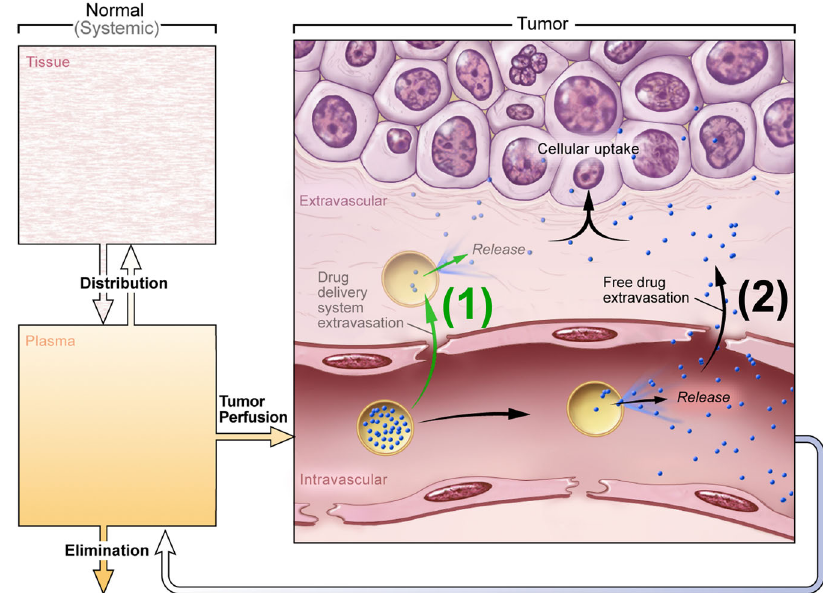
Fig. 1 Schematic of intravascular triggered drug delivery systems (IV-DDS). (1) Traditionally, DDS have been based on passive tumor targeting due to enhanced permeability and retention (EPR), where drug is released following extravasation of the DDS. (2) For IV-DDS, EPR is not relevant: IV-DDS enter the tumor microvasculature of the target region where the release trigger is present, and release the contained drug within the vasculature. The released drug extravasates rapidly into tissue and is then taken up by cancer cells. Both encapsulated and any released drug not taken up by the tumor are distributed systemically and eliminated, symbolized by the systemic plasma and tissue compartments at the left